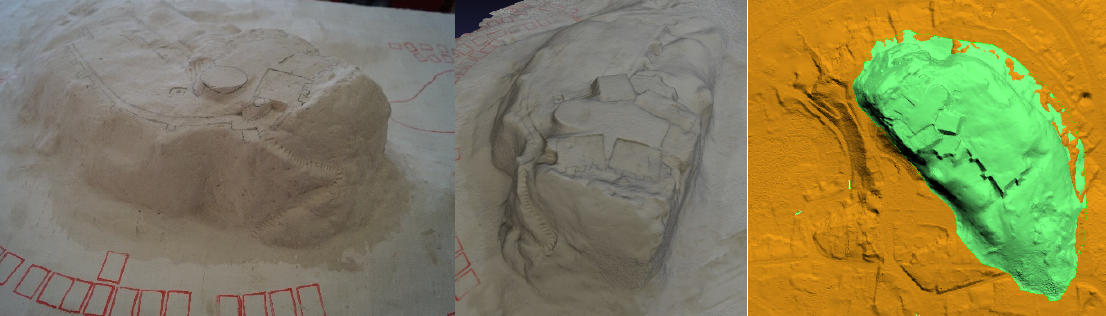
Figure 3. The historic physical 3D model of the Kalkberg (left), the historic digital 3D model from dense image matching (centre) and the combination of two DEMs from both today (orange) and the past (green)